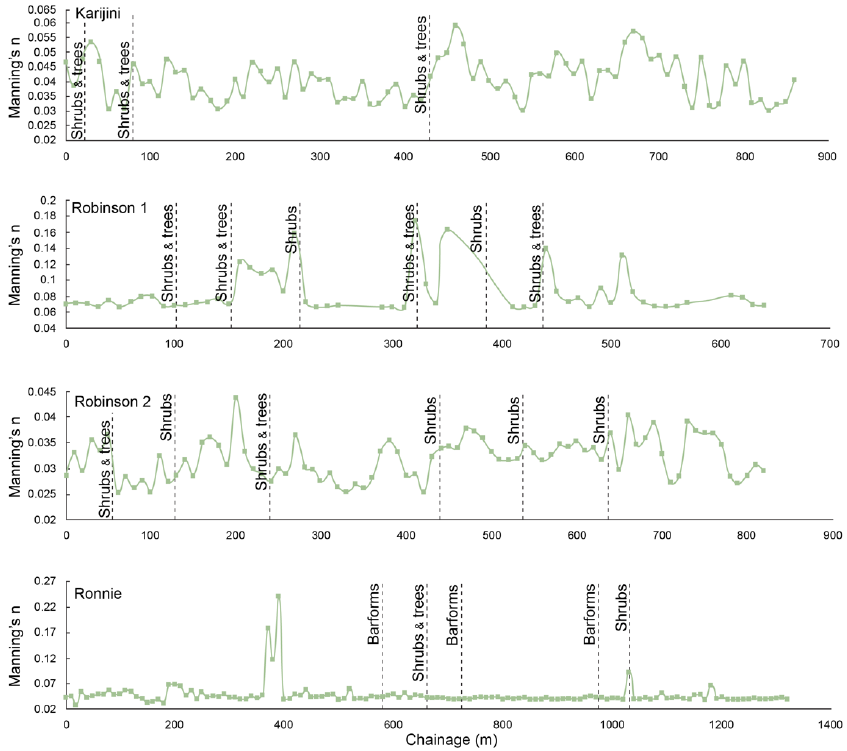
Figure 10. Longitudinal variations in channel roughness for selected